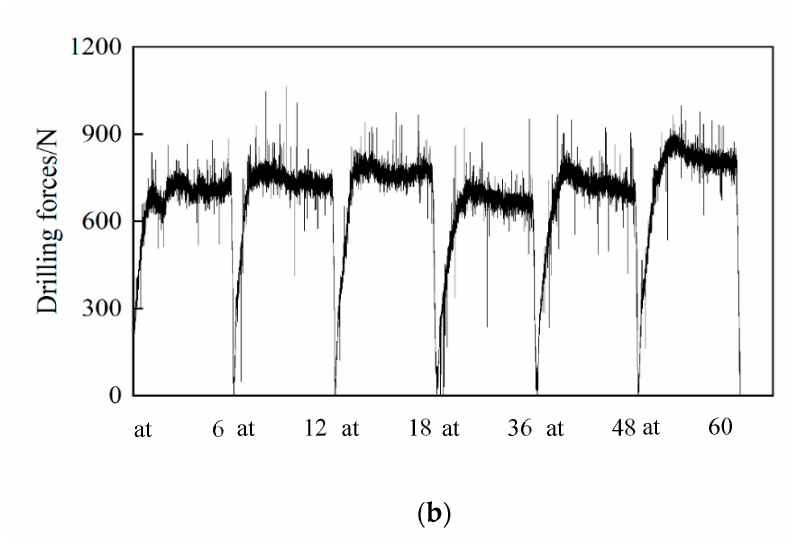
Figure 5. Comparison of drilling forces at drilling speed of 15 m/min, feed rate of 0.04 mm/r, and drilling depth of 6 mm. ( a ) Drilling forces of uncoated bit. ( b ) Drilling forces of coated bit.